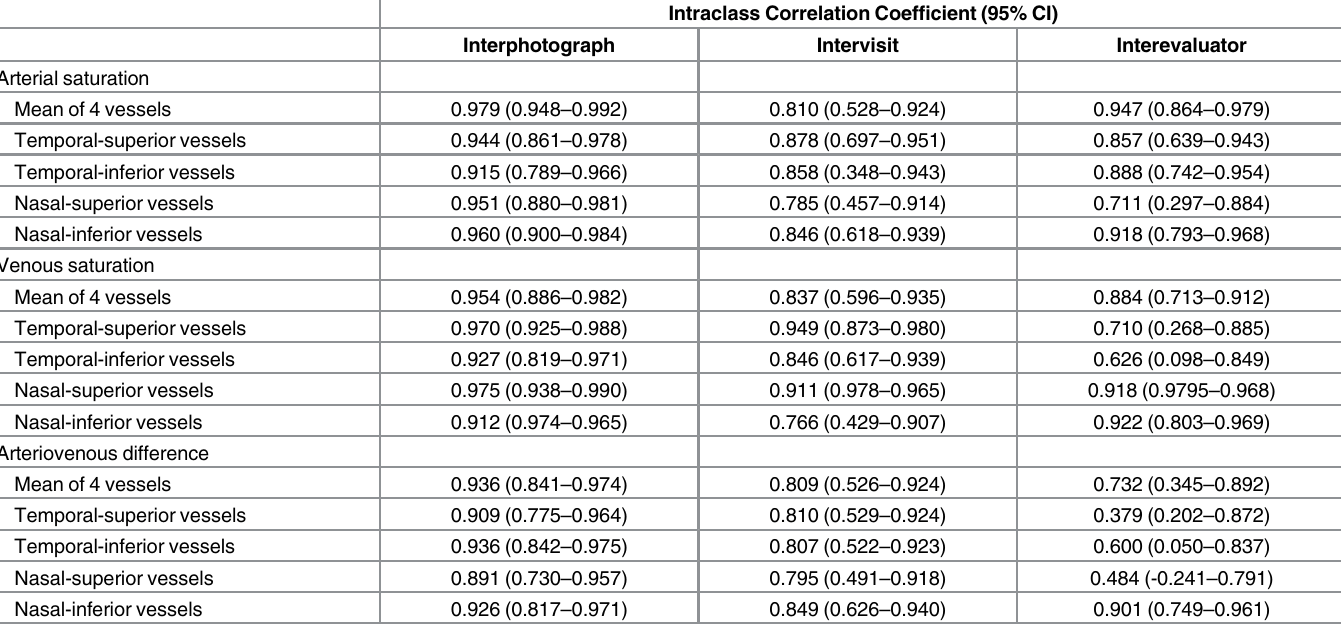
Table 4. Intraclass Correlation Coefficients for Oxygen Saturation in Major Retinal Vessels Measured by Oxymap